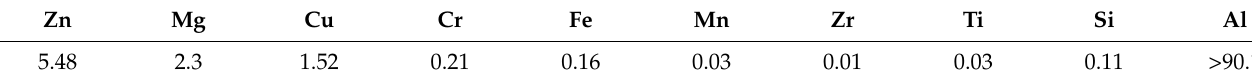
Table 1. Chemical composition of AA7075 sheet (weight %).